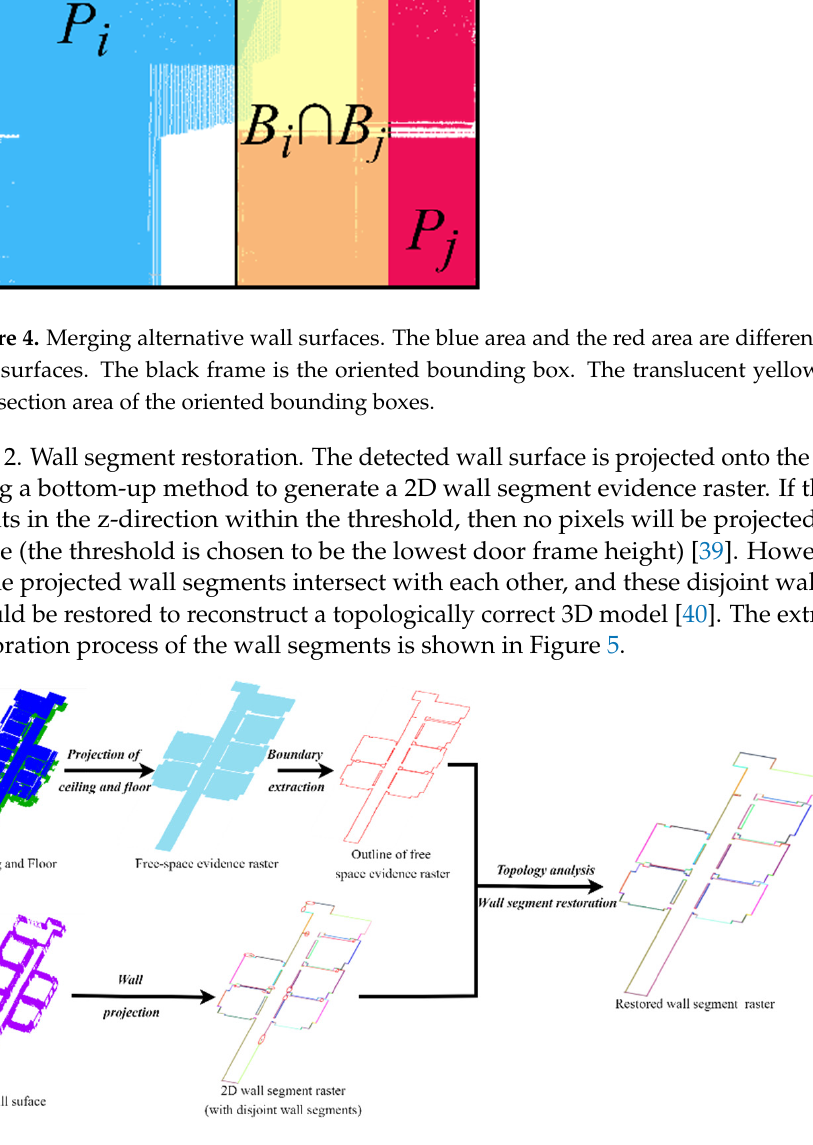
Figure 4. Merging alternative wall surfaces. The blue area and the red area are different alternative wall surfaces. The black frame is the oriented bounding box. The translucent yellow area is the in- tersection area of the oriented bounding boxes.